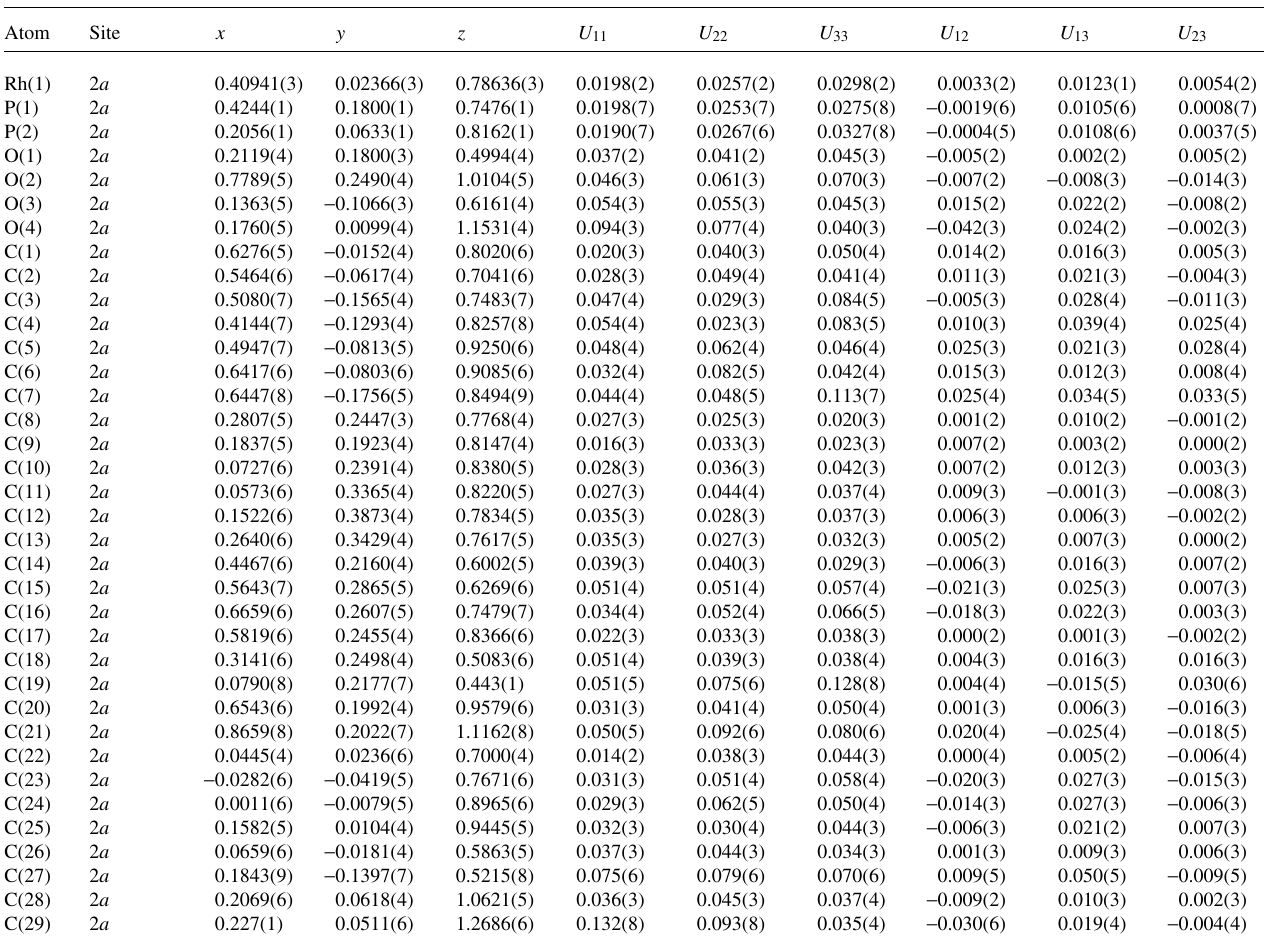
Table 3. Atomic coordinates and displacement parameters (in Å 2 )